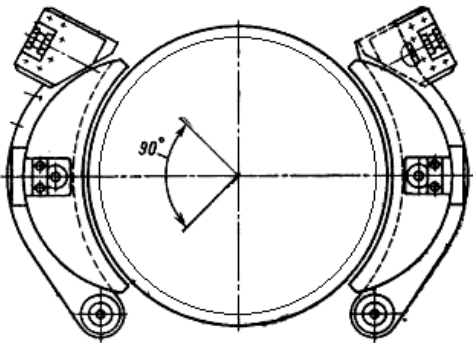
Figure 14. Position of the arc stators relative to the secondary flywheel. Table 8. Parameters of the screw press arc IM.